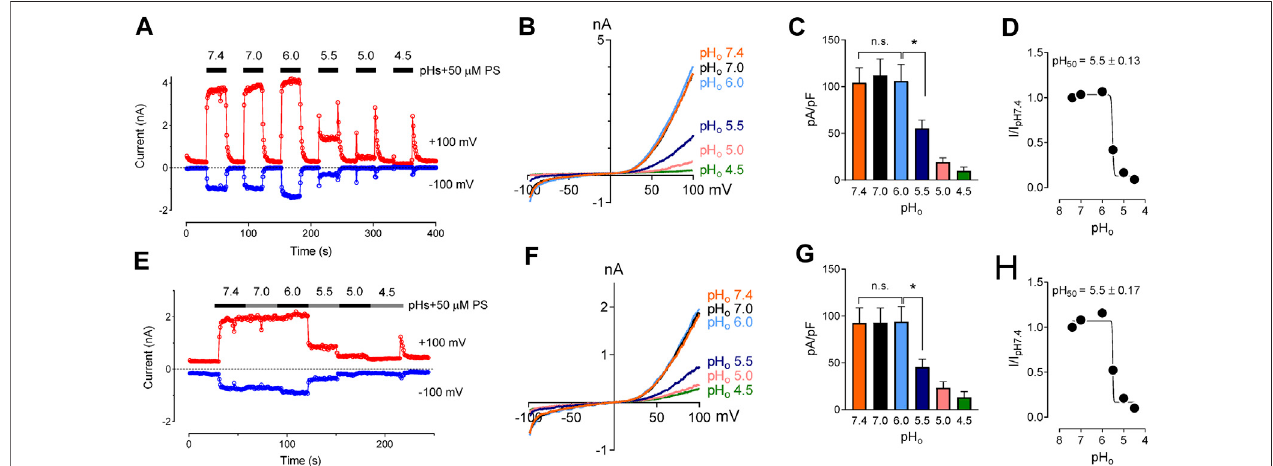
FIGURE 1 | Inhibitory effect of extracellular acidic pH on TRPM3 activation by PS. (A) Time course of TRPM3 currents elicited by voltage ramps ranging − 100 to +100 mV. Both inward and outward currents were completely and reversibly inhibited by pH o 4.5 50 µM PS was applied extracellularly and was washed with PS-free extracellular solution between subsequent PS application. Inward and outward currents were measured at − 100 and +100 mV, respectively. (B) Representative recording of TRPM3 current in (A) by ramp protocols ranging from − 100 to +100 mV at the indicated pH o . (C) Mean current amplitude of TRPM3 at the indicated pH o in (A) (mean ± SEM; n (cid:2) 11, * indicates p < 0.05 by unpaired Student ’ s t-test; “ n.s. ” indicates not statistically signi fi cant). (D) pHo concentration-dependence of TRPM3activationbyPS.TRPM3currentsexertedat+100